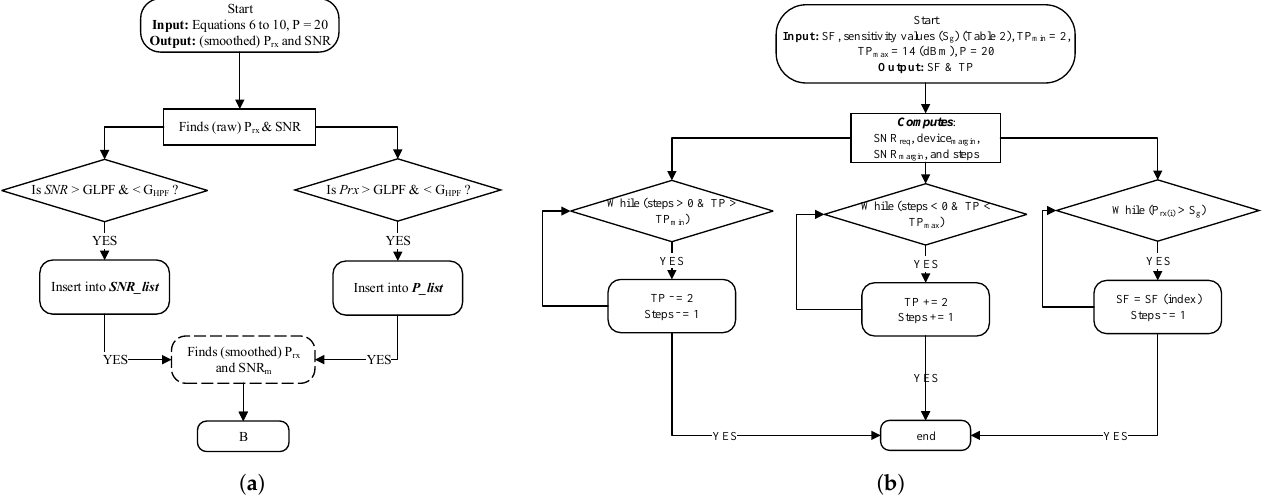
Figure 2. Flow Diagram of the Proposed ADR: ( a ) smoothing of P rx and SNR and ( b ) SF and TP assignment at NS